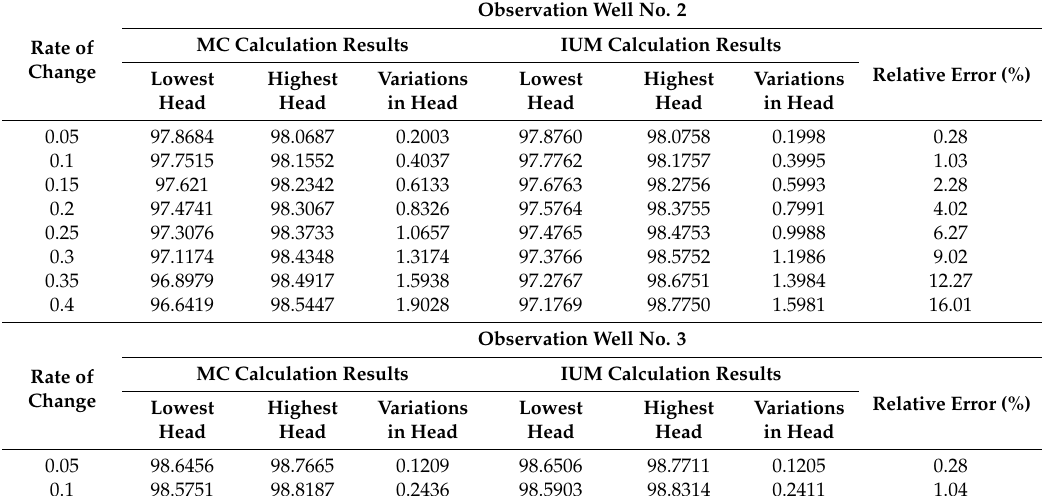
Table 2. Calculation results table for Scenario One (unit: m).